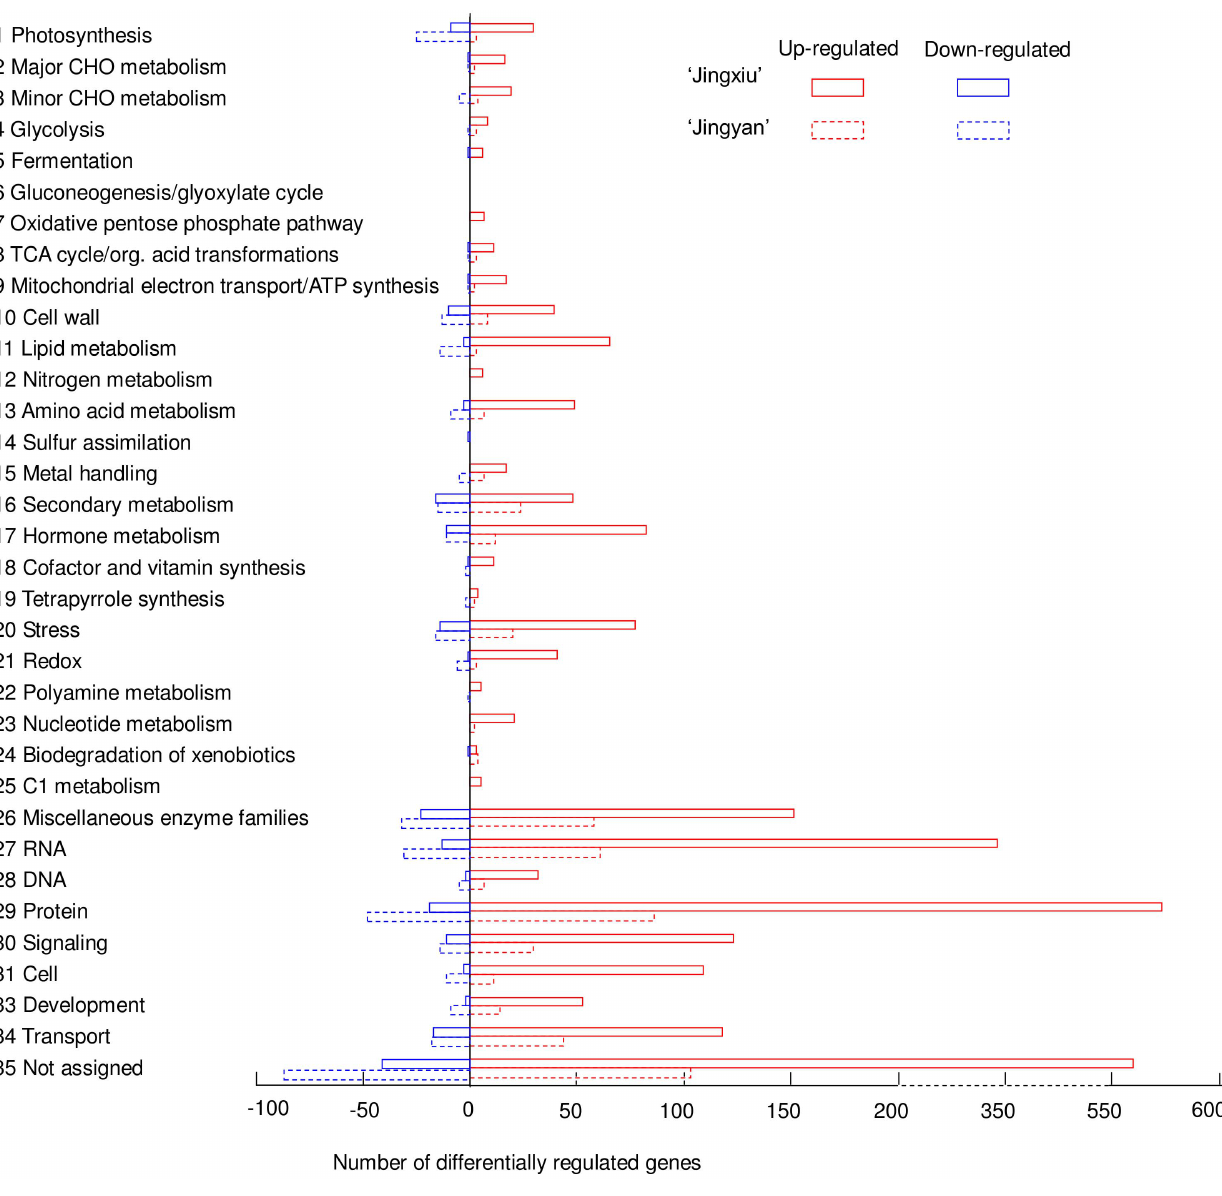
Figure 3. Numbers of down-regulated or up-regulated genes with log2 ratio $ 2 at P , 0.0001 between sunlight-excluded and sunlight-exposed berry skins of ‘Jingxiu’ and ‘Jingyan’ grapes, based on MapMan